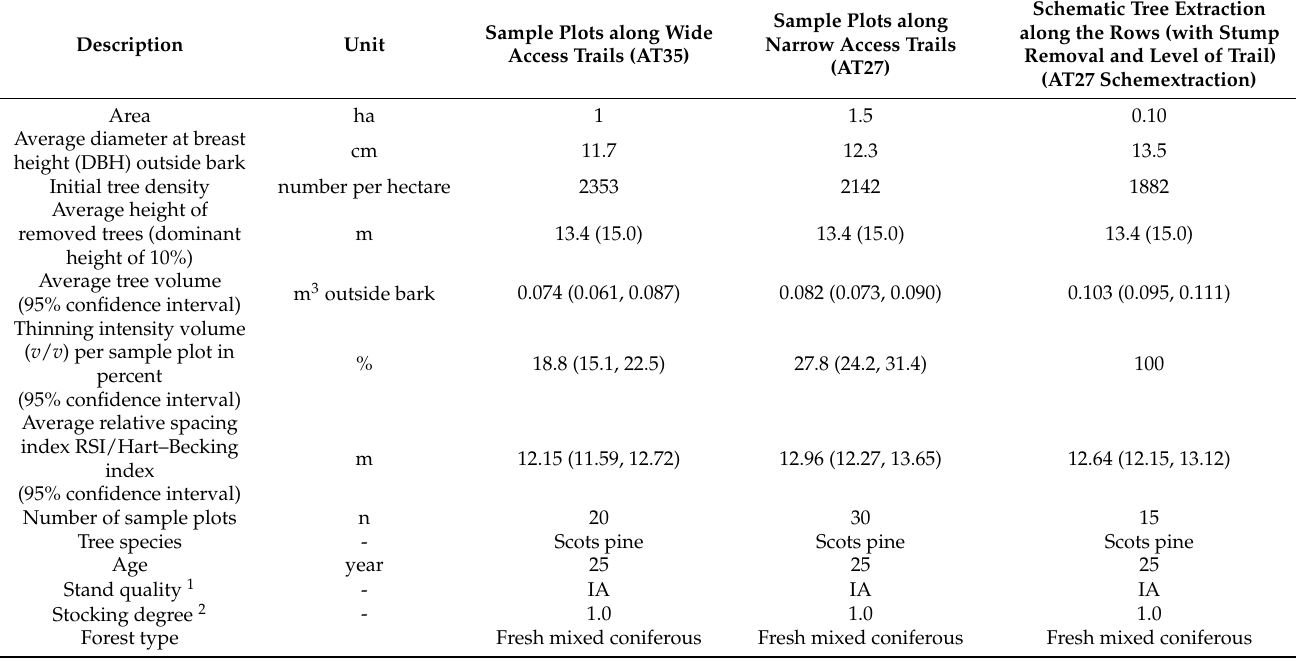
Table 2. Summary of stand characteristics.